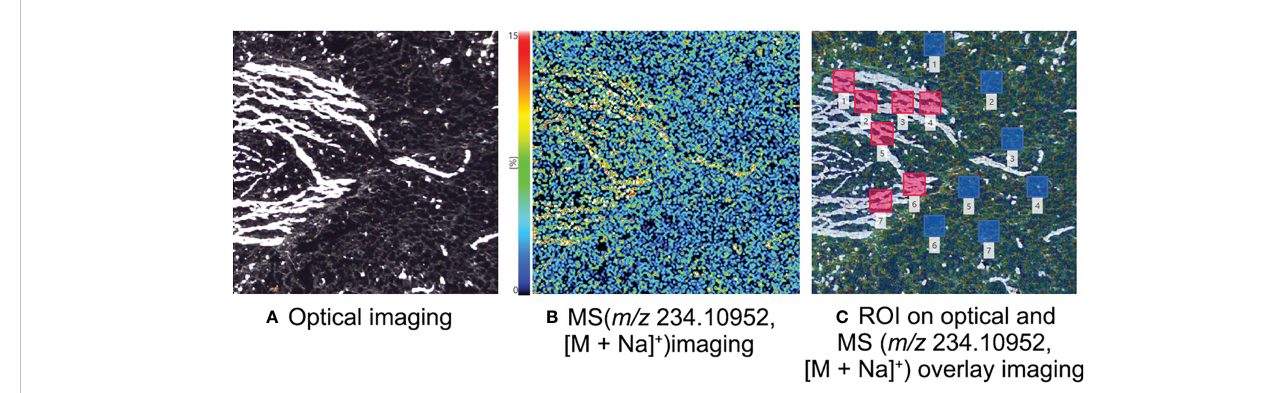
FIGURE 5 MALDI-MSI analysis of mescaline in the subterranean stem slice of Lophophora williamsii . (A) Optical imaging. (B) MS imaging with a resolution of 30 µm ( m/z 234.10952, [M + Na] + ). (C) ROI semi-quantitative regional location on optical and MS overlay